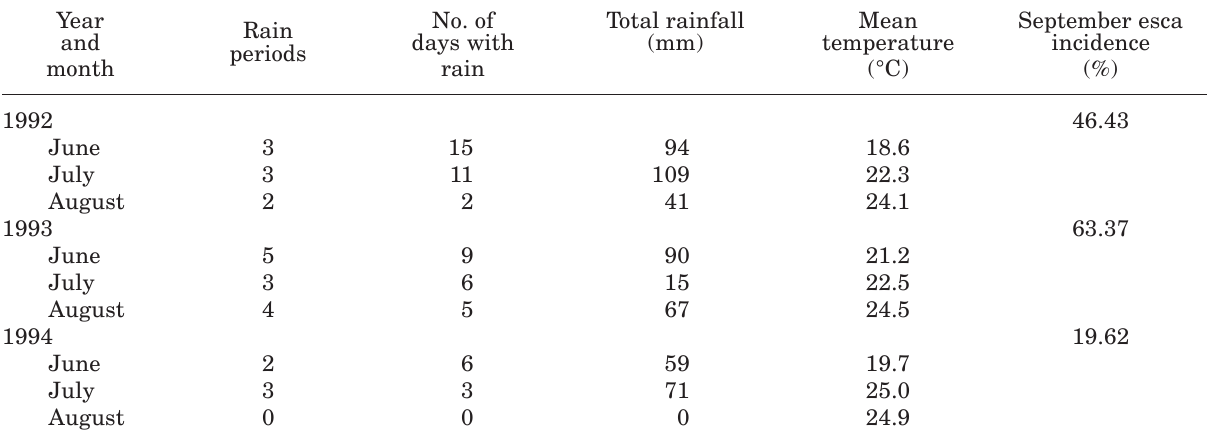
Table 7. Mean monthly temperature, monthly rainfall from June to August and incidence of esca in three vineyards at San Casciano Val di Pesa (Florence), 1992-1994.